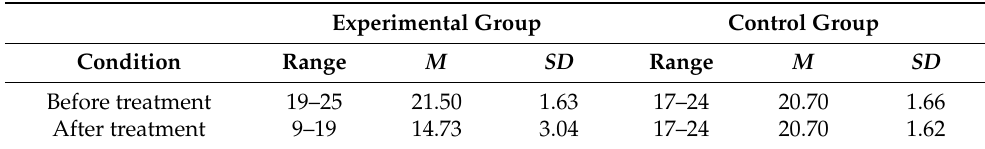
Table 2. Descriptive statistics for acne severity in the